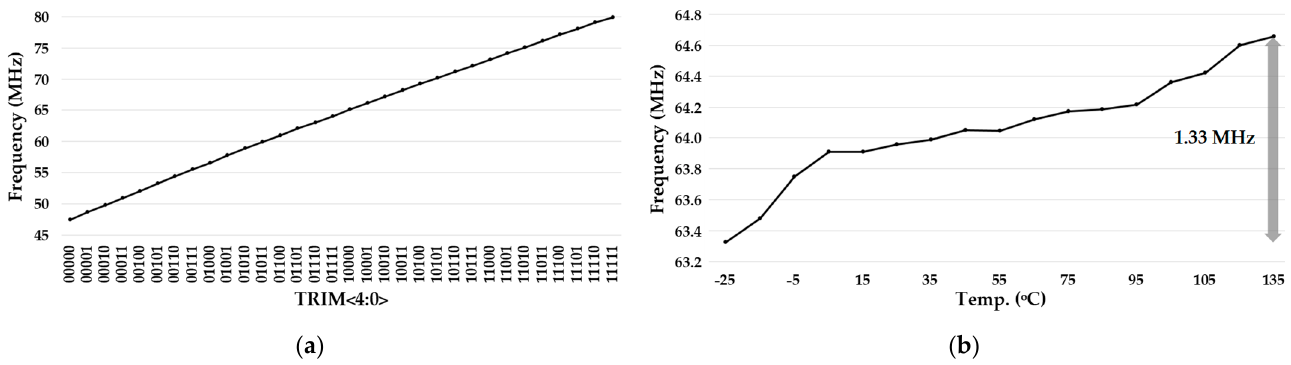
Figure 9. Post-layout Monte-Carlo simulation of the proposed relaxation oscillator.